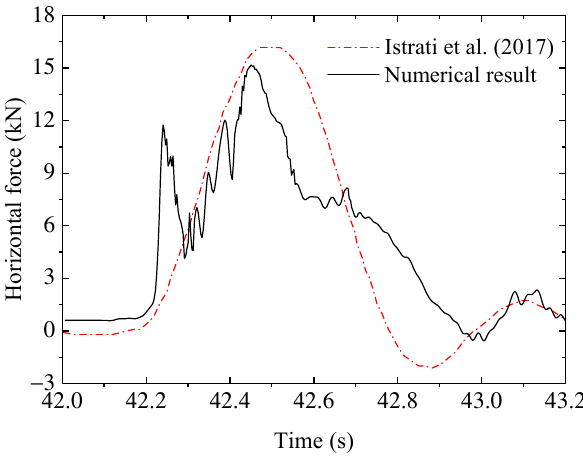
Figure 9. Comparison of the time histories of the horizontal force between the numerical result of current study and the experimental result of Istrati